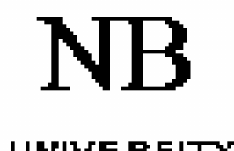
Figure 6. Original watermark (64 × 64).